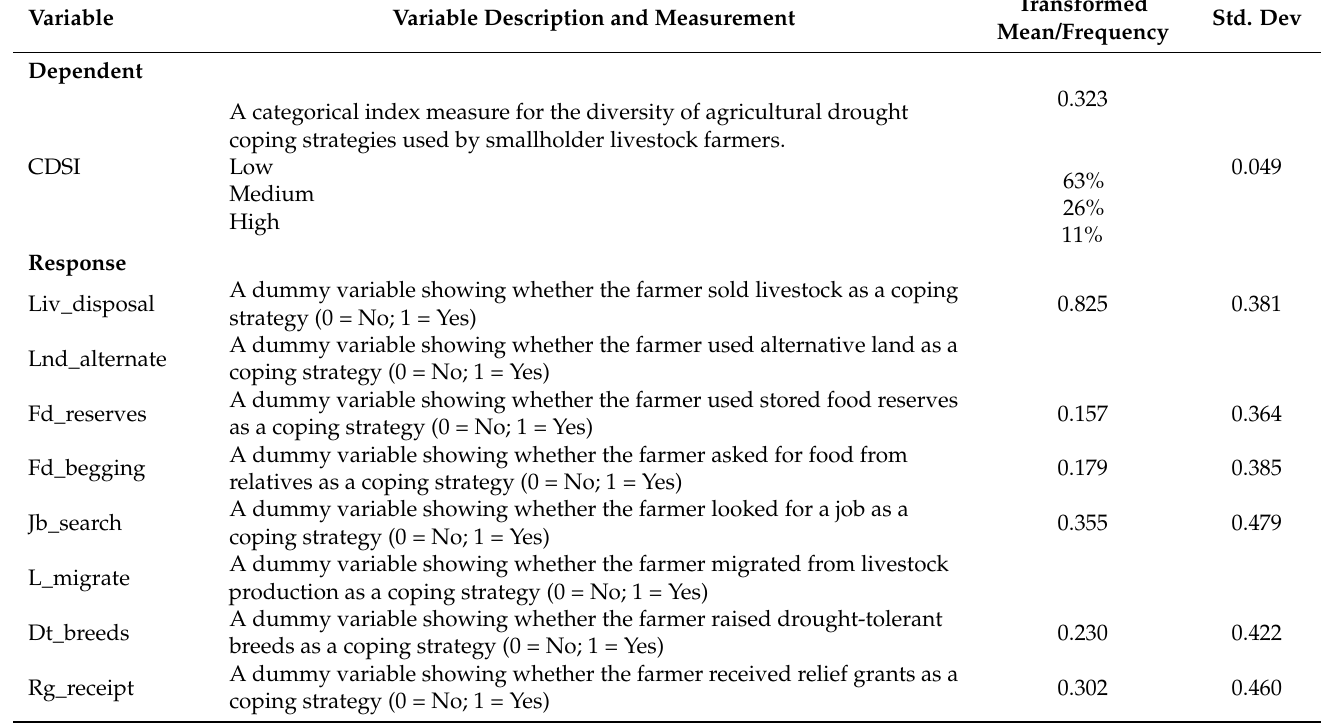
Table 2. Variables included in the model and descriptive statistics ( n = 217). Variable Description and Measurement